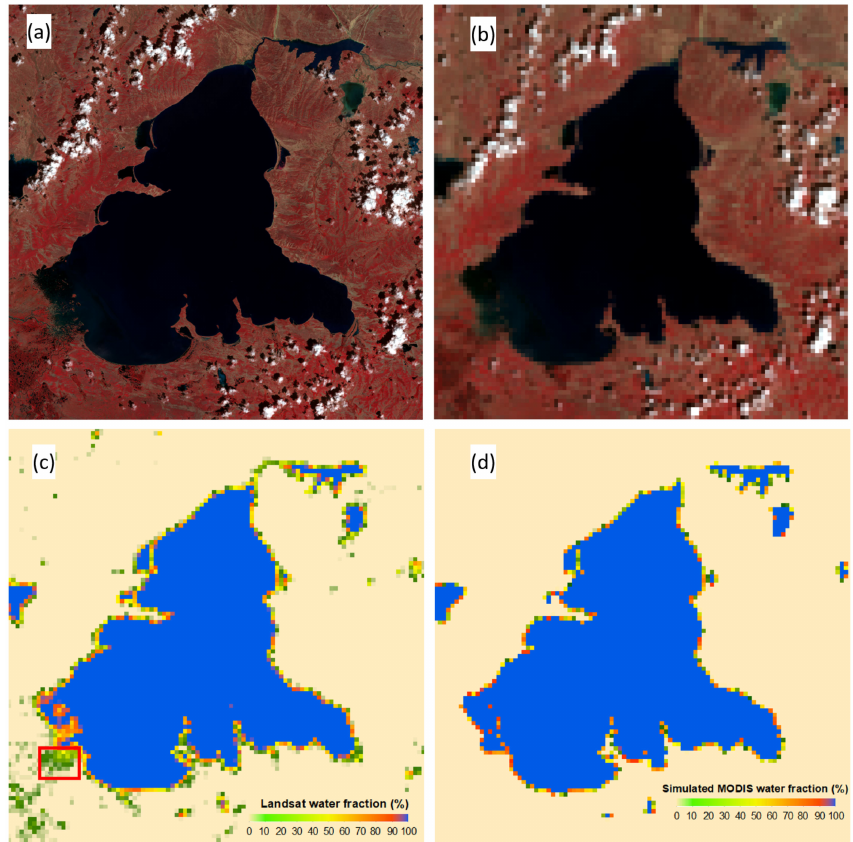
Figure 4. The false color composite Landsat OLI image (acquisition date: 2014 / 08 / 16) and the simulated MODIS image and the comparison of water map from the OLI data and this work for Ngoring Lake: ( a ) false color composite OLI image, ( b ) false color composite simulated MODIS image, ( c ) water fraction reference map at 480 m resolution, ( d ) map of subpixel water fraction computed from simulated MODIS data.